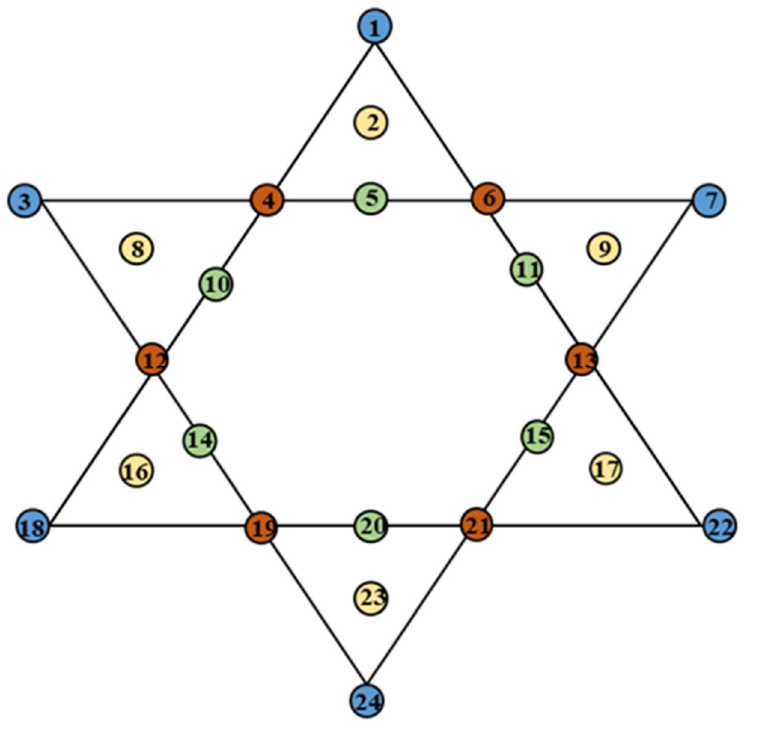
Figure 8. Six-sided star model (When the XOR operation is performed subsequently, the corresponding operation is performed according to the color).